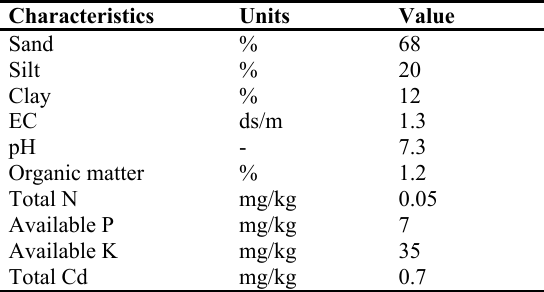
Table 1. Experimental soil